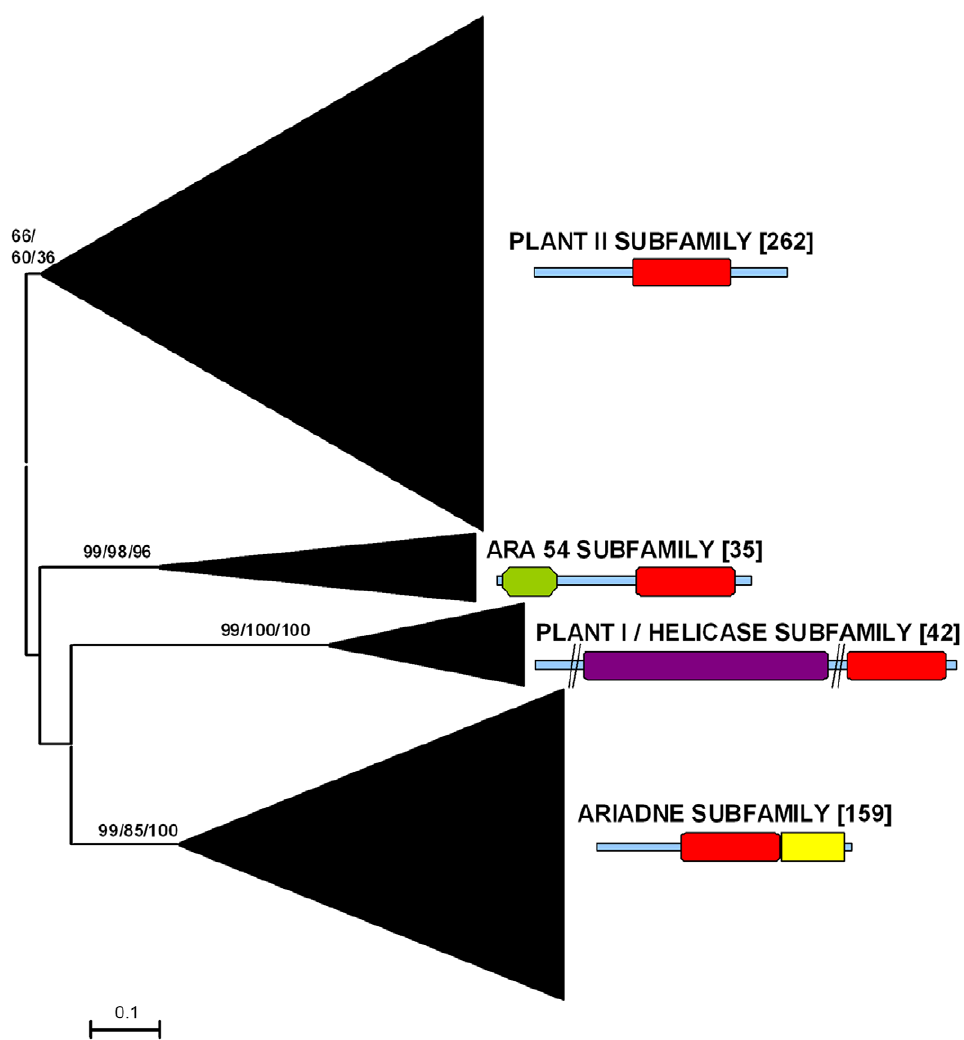
Figure 1. Basic result for the general analyses including 498 plant RBR sequences. The main branches that correspond to the four subfamilies are indicated. Numbers above those branches correspond to bootstrap support, in percentages. The three numbers correspond to Neighbor-joining (NJ), maximum parsimony (MP) and maximum likelihood (ML) analyses (order: NJ/MP/ML). Numbers in brackets refer to the number of protein sequences which are included in a branch. The typical structures of the proteins in the subfamilies are also indicated (red: RBR supradomain; green: RWD/GI domain; purple: DEAD/DEAH helicase domain; yellow: Ariadne domain). The slashes in the Helicase-containing protein are included to reflect that these proteins are usually much longer than shown here and two regions have been deleted. See ref. [5] for further details of these structures.